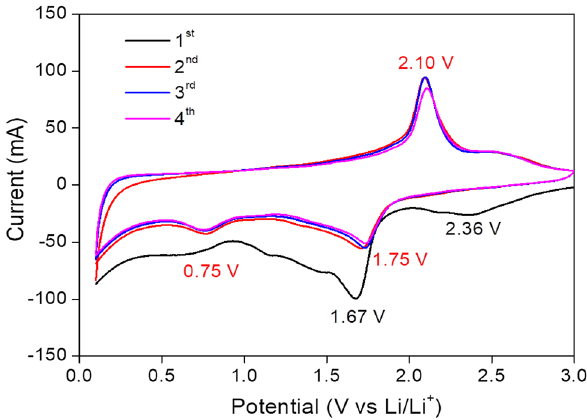
2 NPs Fig. 7 Cyclic voltammogram of B-TiO